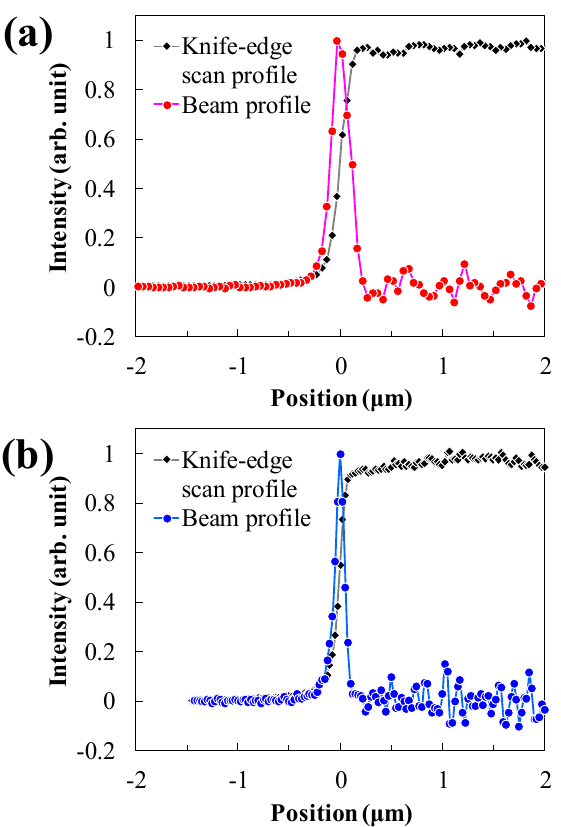
Figure 3. Typical intensity distributions of focused beam at a photon energy of 10 keV measured using the knife-edge scanning method. The focused beam size of 210 nm × 120 nm (full width half maximum (FWHM)) was evaluated in the ( a ) vertical direction and ( b ) horizontal direction. 30 shot intensities were averaged for each data point at an X-ray free-electron laser (XFEL) repetition rate of 30 Hz.